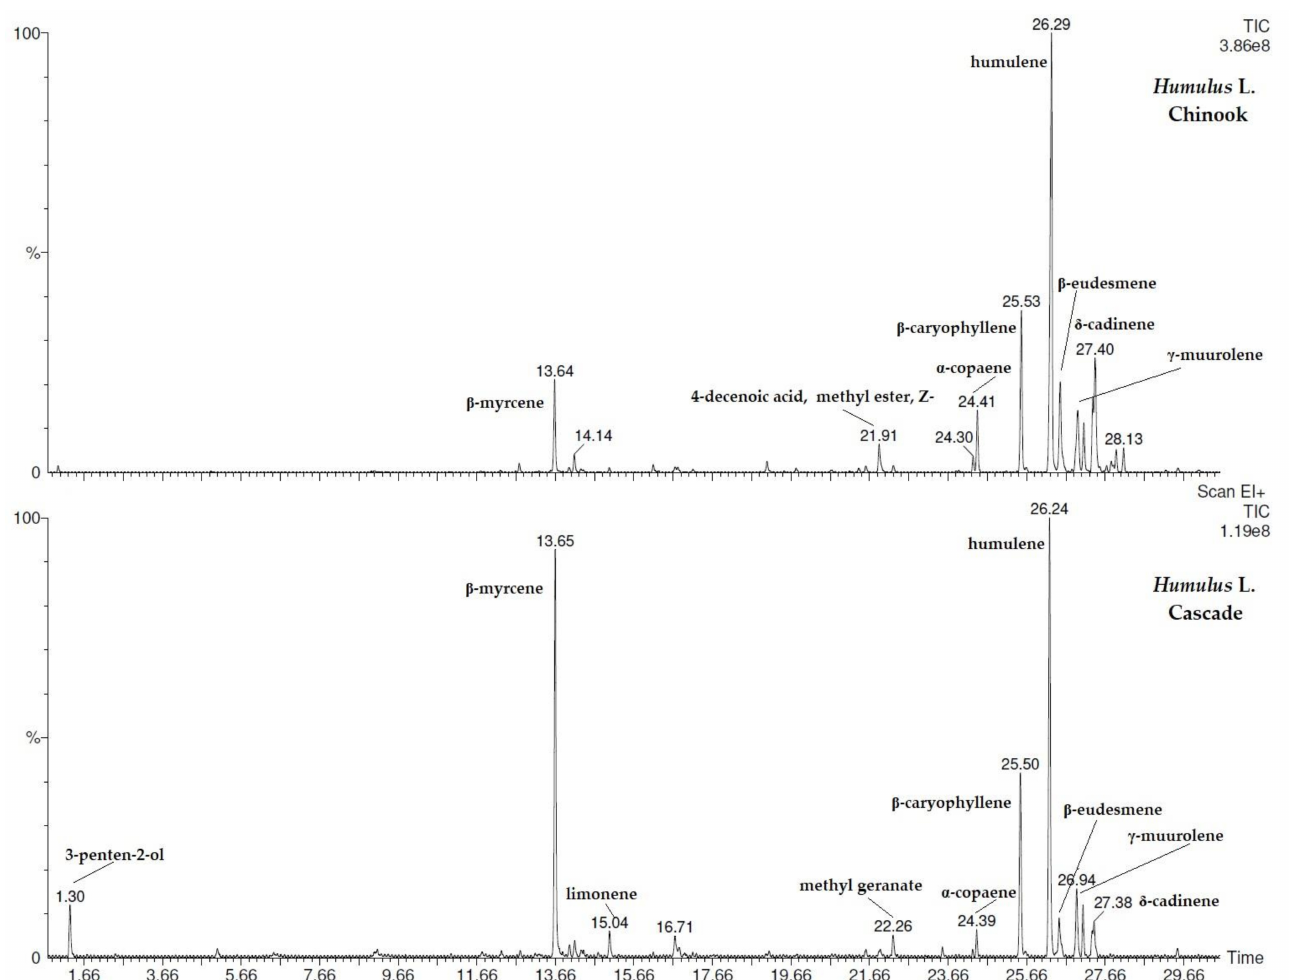
Figure 3. Chromatograms of the Chinook and Cascade hop dried